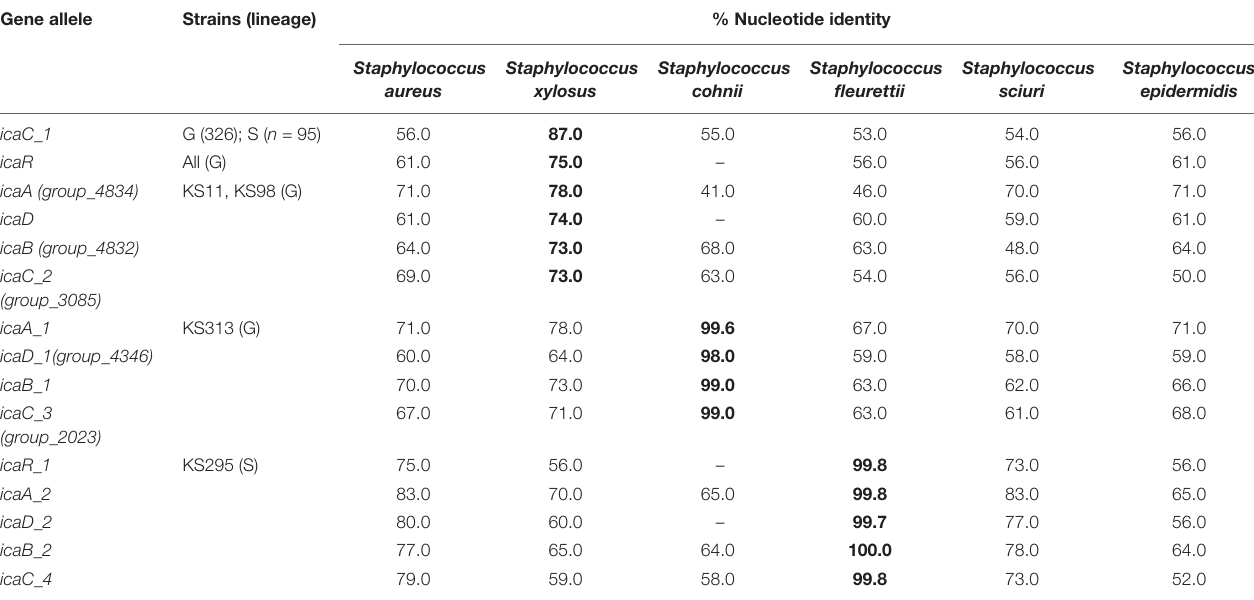
TABLE 1 | ica genes carried by four Staphylococcus saprophyticus strains in lineage G and S and their nucleotide homology with those found in other staphylococcal species. Gene allele Strains (lineage) % Nucleotide